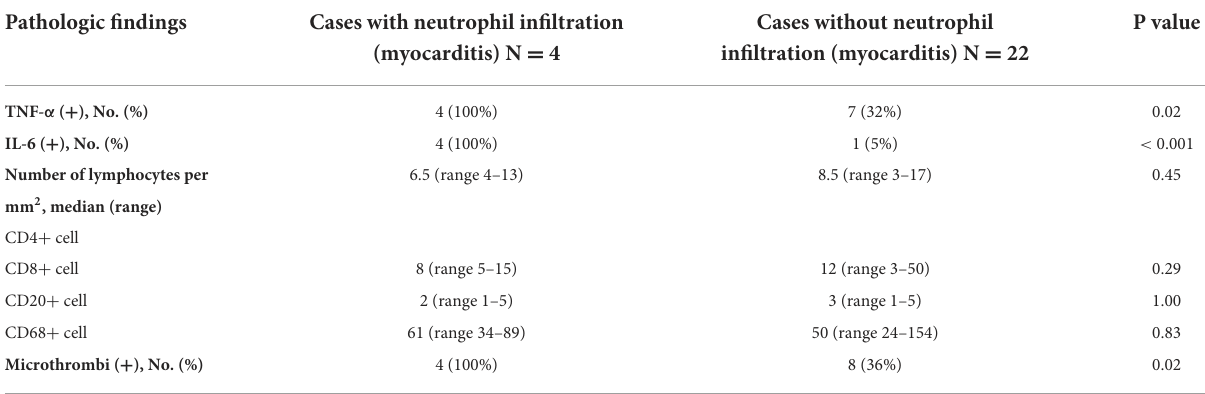
TABLE 1 Pathologic findings of cases with vs. without neutrophil